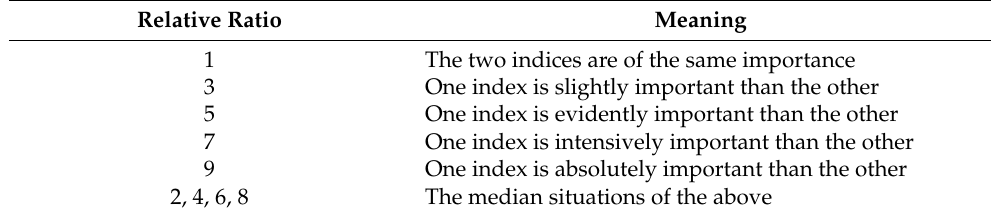
Table 1. The content of the scaling method.